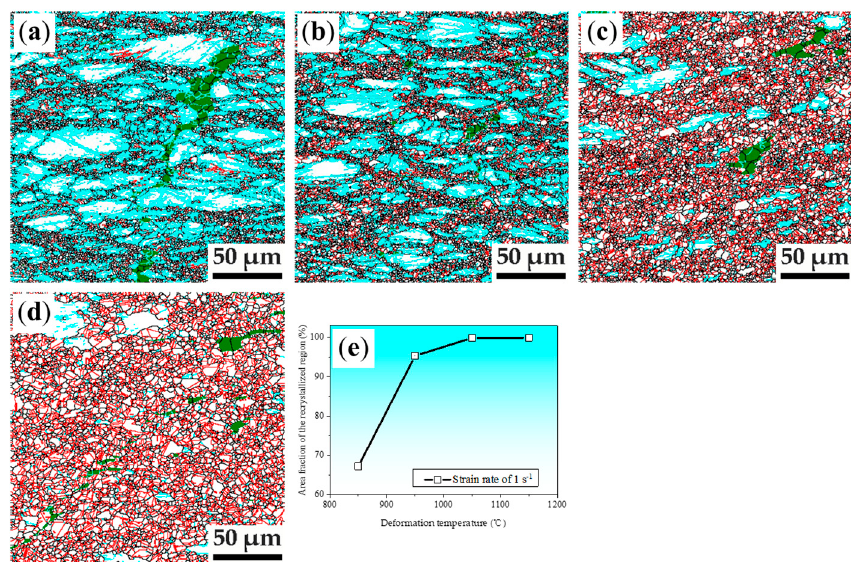
Figure 5 . High temperature deformation microstructure revealed by the grain boundary maps of specimens compressed at ( a ) 850 °C, 0.1 s − 1 ; ( b ) 850 °C, 1 s − 1 ; ( c ) 850 °C, 10 s − 1 ; ( d ) 950 °C, 10 s − 1 ; black lines present HAGBs (>15°), cyan lines present LAGBs (2-15°), red lines present TBs, green color present BCC phase; ( e ) the area fraction of recrystallized region.